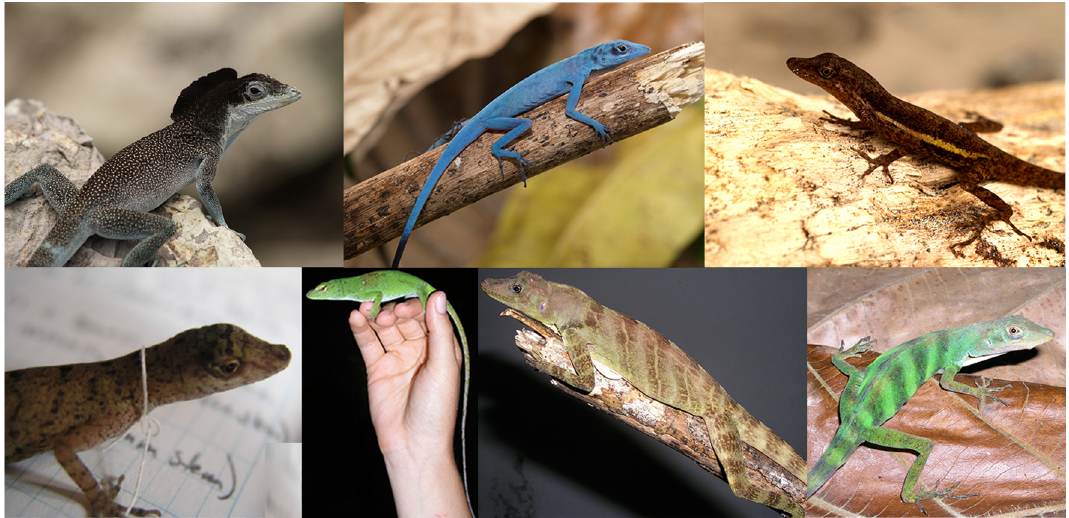
Figure 1. Seven species of anoles found on the islands in the Eastern Tropical Pacific (ETP). Top row, left to right: Dactyloa agassizi (Isla Malpelo), Dactyloa gorgonae (Isla Gorgona), Norops townsendi (Isla Cocos). Bottom row: Norops medemi , Norops parvauritus , Dactyloa princeps , Dactyloa chocorum (all Isla Gorgona).